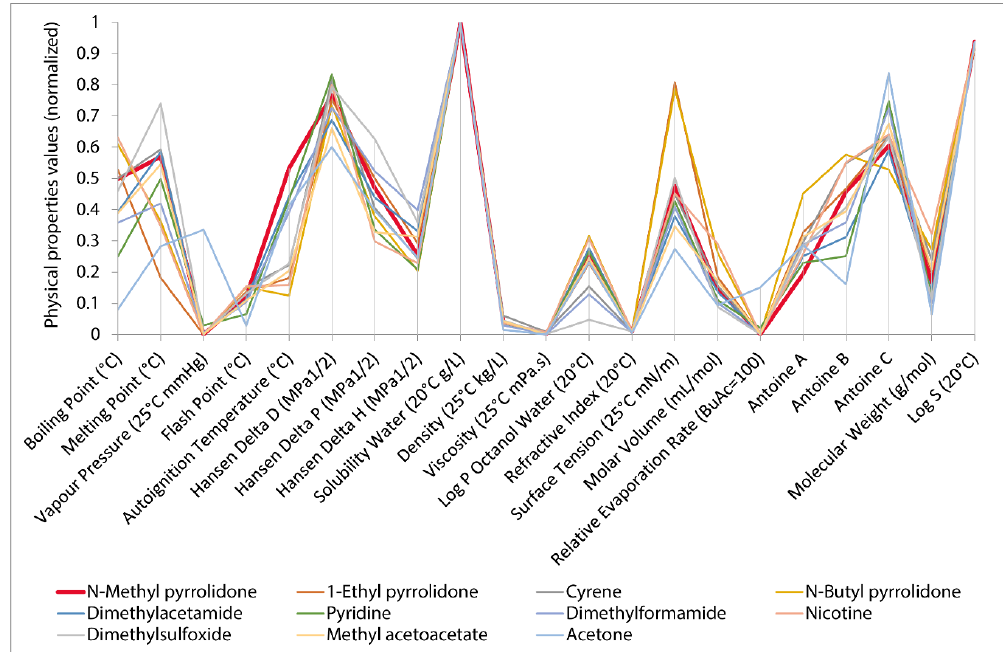
Figure 10. Normalized visualization of 10 solvents from candidate list with smallest Hansen distance towards NMP. Solvents are represented by a polyline.